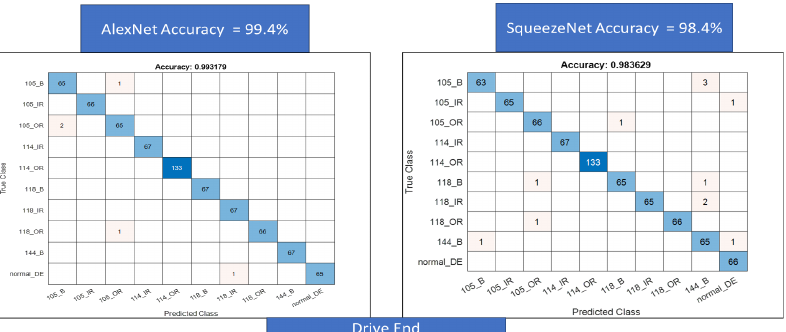
Figure 18. Figure showing Confusion Matrix for AlexNet and SqueezeNet using Transfer learning on the Color recurrence plots combining the classes into a single classification problem.